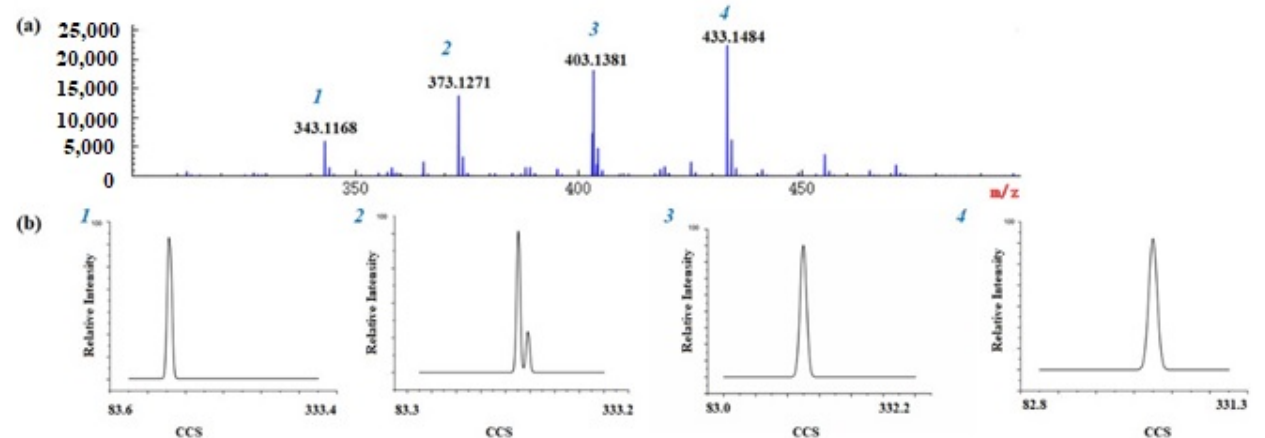
Figure 3. MS spectra ( a ) and UMA spectra ( b ) of five polymethoxylated flavones in Chenpi MS spectra of a, (1) 3,5,6,7- tetramethoxyflavone, (2) tangeretin and sinensetin, (3) nobiletin, (4) 3,5,6,7,8,2 ′ ,3 ′ -heptamethoxyflavone. UMA spectra of b, (1) 3,5,6,7-tetramethoxyflavone, (2) tangeretin and sinensetin, (3) nobiletin, (4) 3,5,6,7,8,2 ′ ,3 ′ -heptamethoxyflavone. The x-axis represents CCS values and Y-axis represents relative abundance.